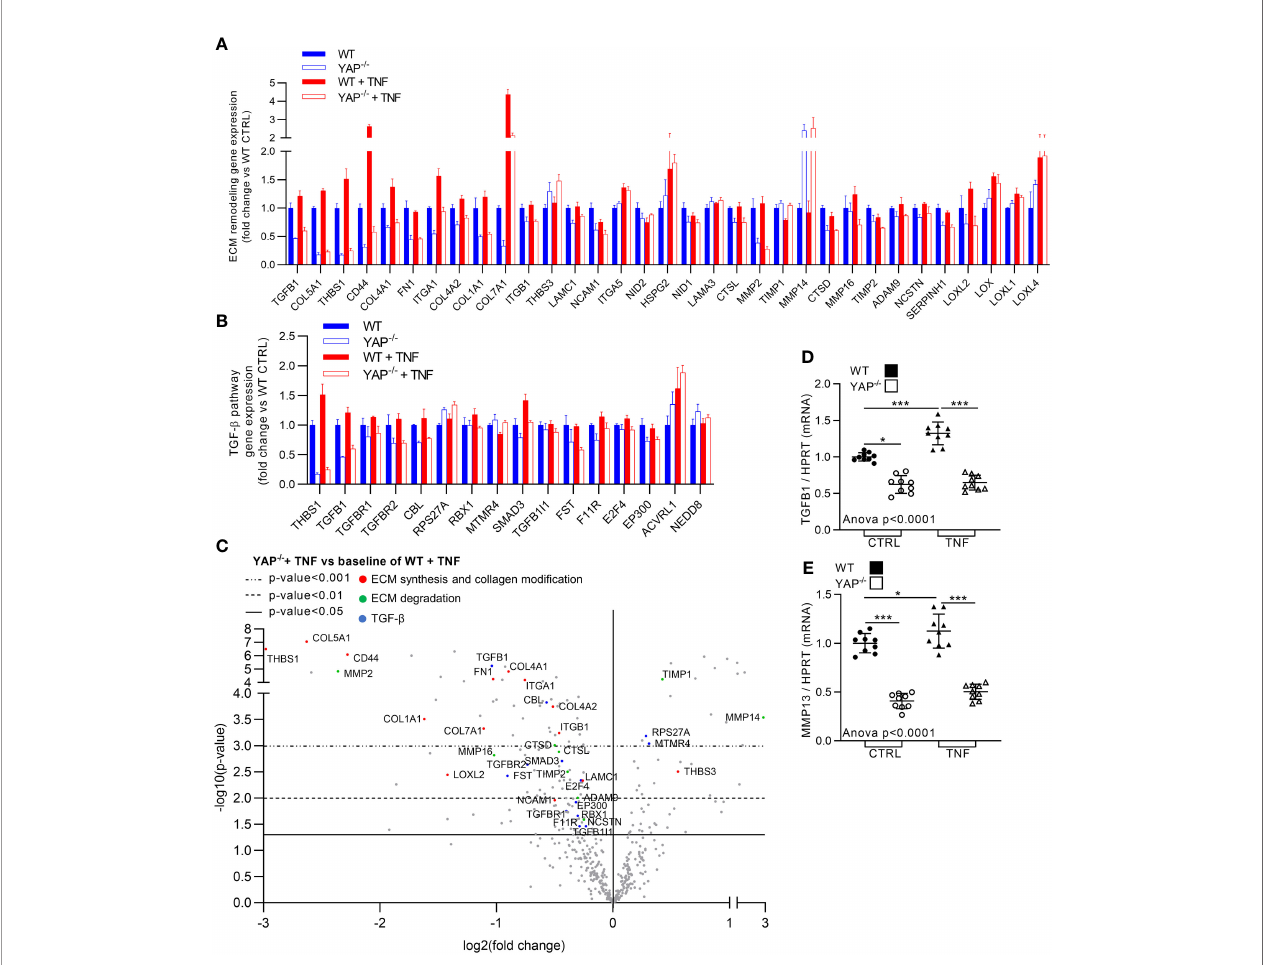
FIGURE 6 | YAP drives TNF effect on pro- fi brotic genes expression. HEK293 cells were cultured and treated with TNF as described in Figure 1 . (A, B) Nanostring fi brosis panel histograms for pro- fi brotic pathways in the four groups; depicted genes were selected if at least one comparison between 2 groups gives a p-value <0.05 and must be related to ECM remodeling (namely, ECM degradation, ECM synthesis and collagen biosynthesis and modi fi cation) (A) or TGF- b signaling (B) . (C) Volcano plot representation for differential genes expression in YAP − / − + TNF group versus the baseline of WT + TNF group; depicted genes are signi fi cantly differentially expressed and are related to ECM synthesis and collagen biosynthesis and modi fi cation (red), ECM degradation (green) and TGF- b (blue) pathways. (D, E) RT-qPCR quanti fi cation of TGFB1 and MMP13 expression normalized to HPRT expression. For RT-qPCR, results are representative of three independent experiments with 3 biological replicates for each experiment (n = 9 per group) with T-test or one-way ANOVA test and FDR corrected for multiple comparisons post hoc tests performed between conditions: *p < 0.05; ***p < 0.001. Data are expressed as fold change vs. control and presented as individual values with mean ± SD (D, E) or presented as histogram with mean + SD (A, B)